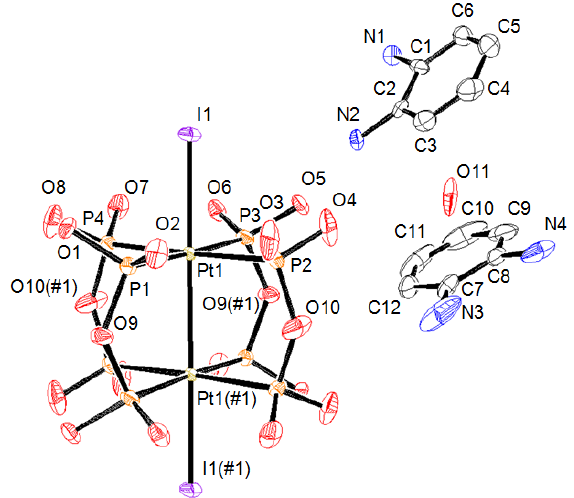
Figure 1. ORTEP representation of the molecular structure of 1 . Thermal ellipsoids are displayed at the 50% probability level. Hydrogen atoms are omitted for clarity. The occupancy of I1 and O11 are 50%. Symmetry transformations used to generate